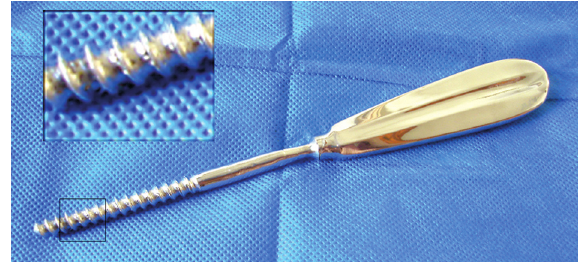
Figure 3 – Cavernotome.